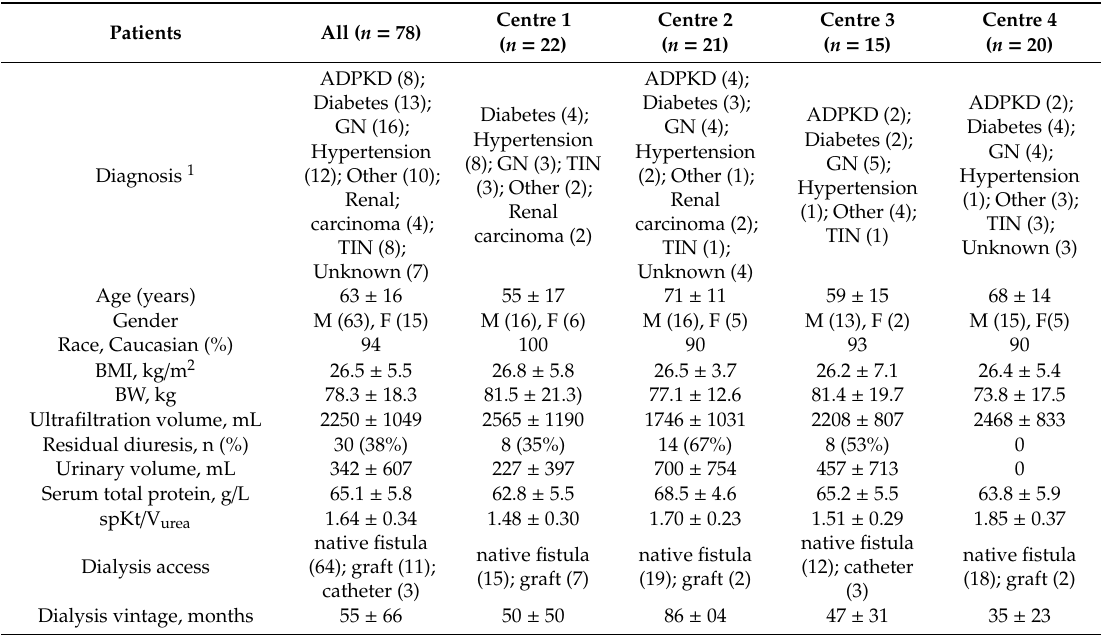
Table 2. Clinical data of the CKD patients. Numerical values are given as number of patients in parentheses or as mean ±